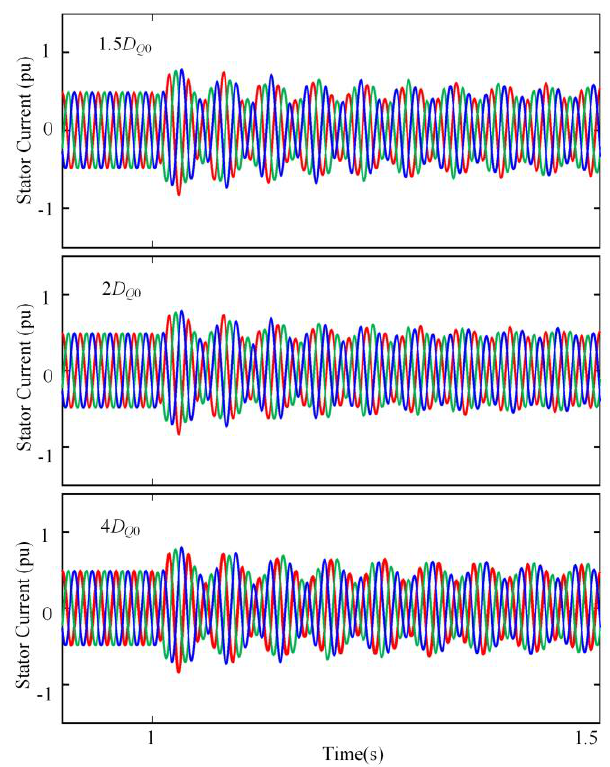
Figure 16. Waveform of stator currents.